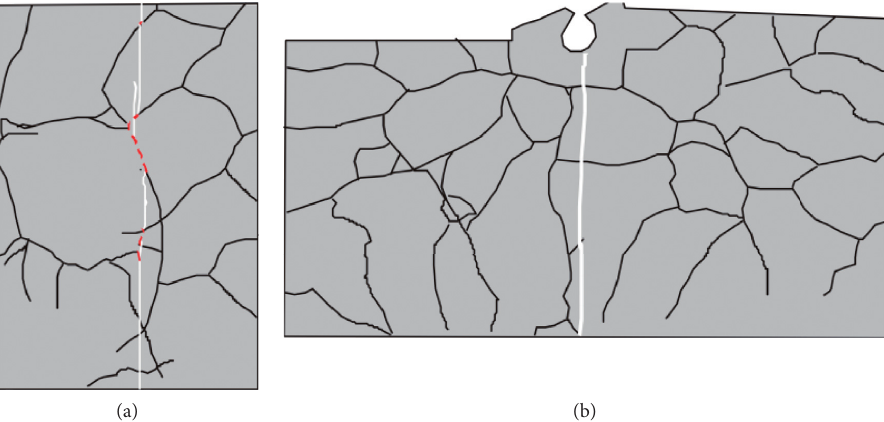
Figure 8: Schematic of the influence of horizontal stress difference on hydraulic fracture geometry [74]. (a) Horizontal stress difference K h � 0.25. (b) Horizontal stress difference K h � 2.5 ( K h � ( σ y ‒ σ x )/ σ x where σ x and σ y are, respectively, the minimum and maximum horizontal principal